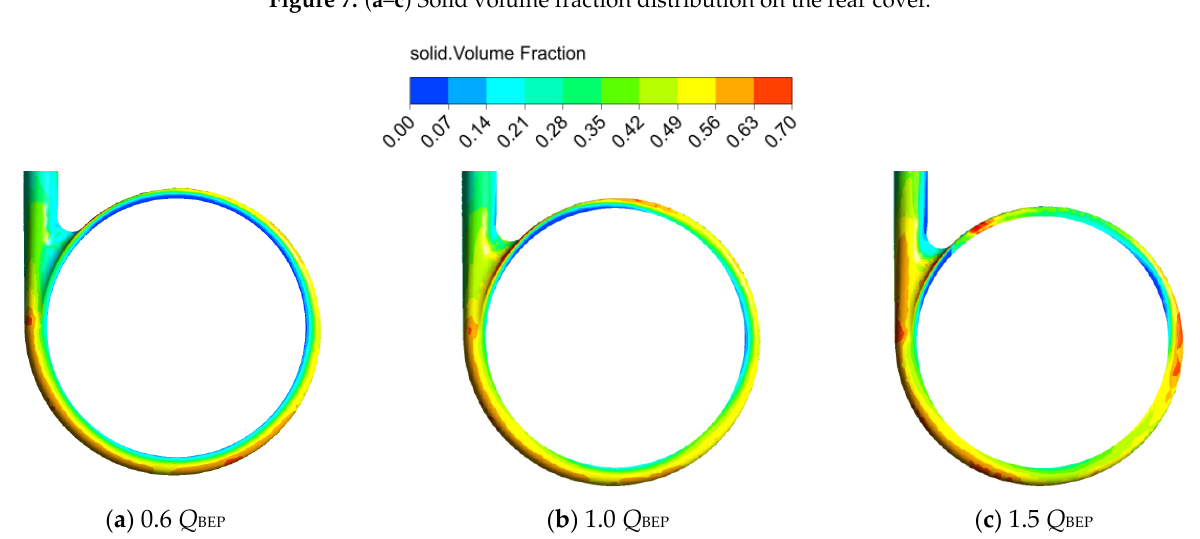
Figure 8. ( a – c ) Solid volume fraction distribution on the front cover.